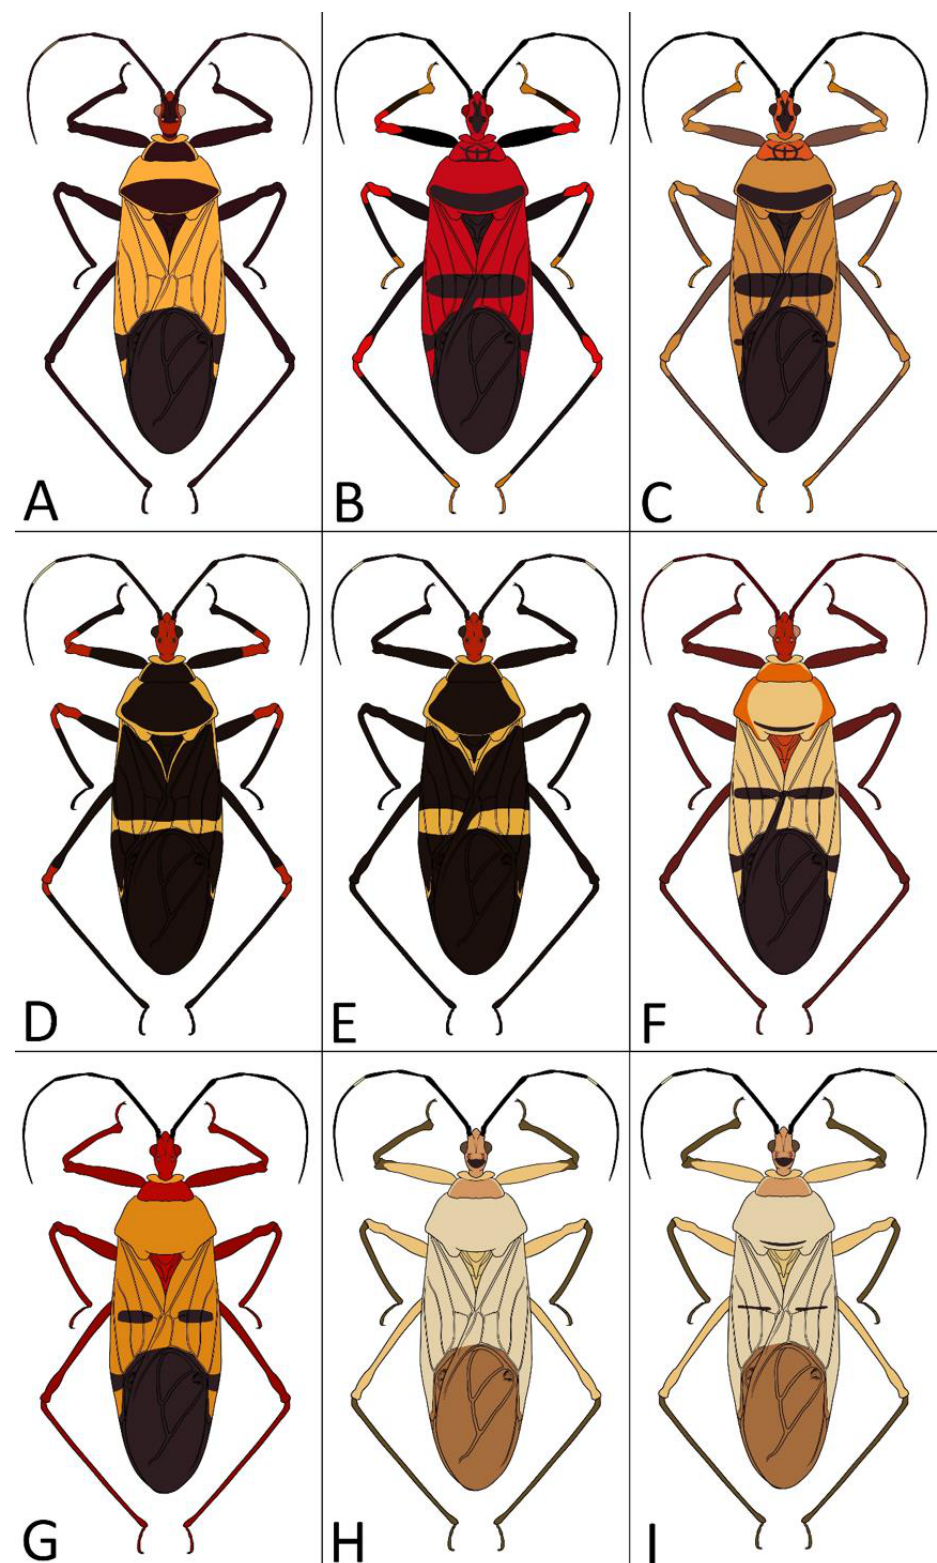
Figure 28. Dorsal colour patterns of the representatives of Phonoctonus Stål, 1853: ( A ) Phonoctonus bifasciatus Villiers, 1948; ( B , C ) P. caesar Haglund, 1895; ( D ) P. elegans Varela, 1904; ( E ) P. fairmairei Villiers, 1948; ( F ) P. fasciatus (Beauvois, 1805); ( G ) P. grandis Signoret, 1860; and ( H , I ) P. immitis Stål, 1865.